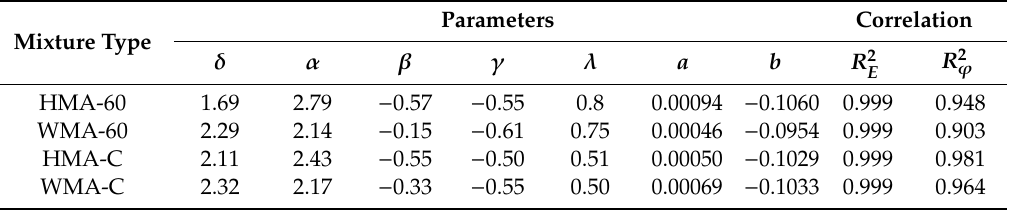
Table 8. Fitting parameters of the GSM (Polynomial equation).